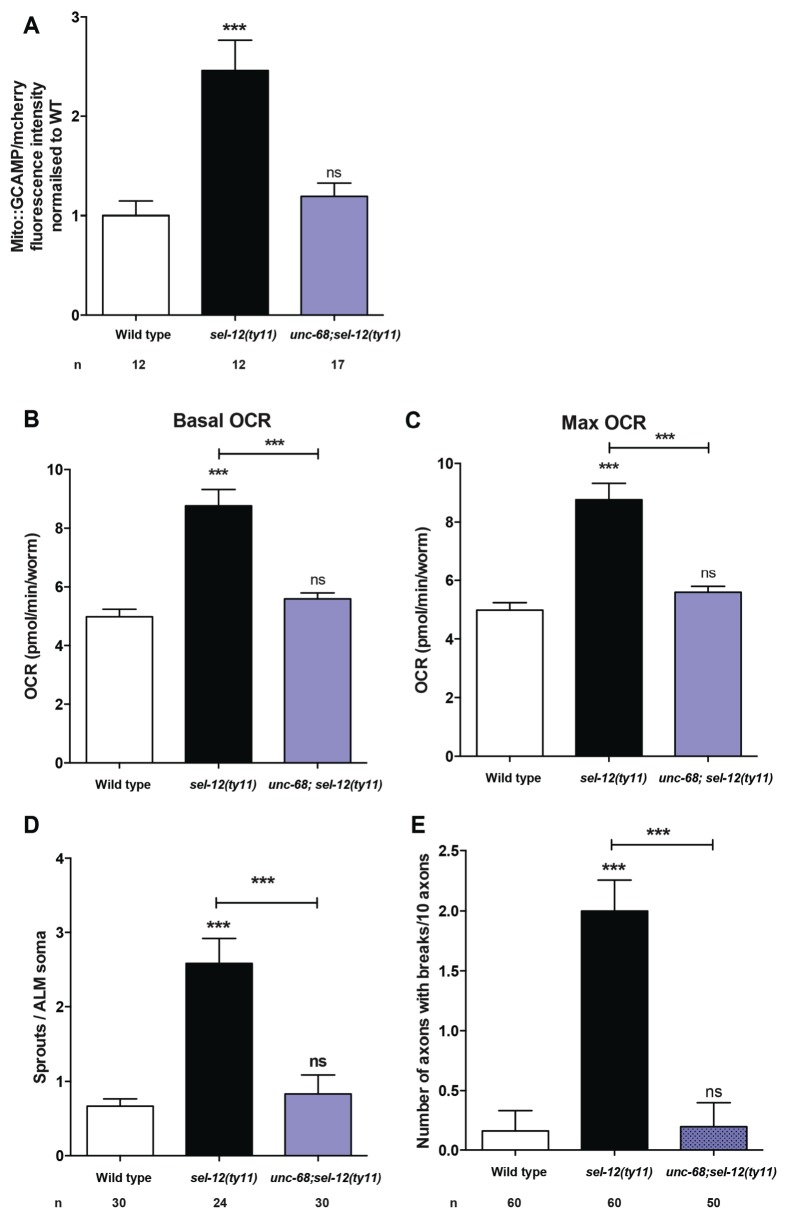
Loss of ryanodine receptors results in the improvement of neurodegeneration in sel-12 null animals.(A) Quantification of mitochondrial Ca2+ using animals expressing mito::GCaMP6 and mCherry in their mechanosensory neurons (takEx415). (B) Basal and (C) maximal respiration rates of wild type, sel-12, and unc-68; sel-12(ty11) mutant animals at day 1 of adulthood. (D) Quantification of aberrant structures (sprouts/branches) on ALM neuronal soma and (E) frequency of breaks in ALM and PLM neuronal processes at day 1 of adulthood. n = number of animals analyzed per genotype. Data are displayed as mean ± SEM, and all comparisons have been made to wild type animals unless otherwise indicated. ns p>0.05, ***p<0.0001 (One way ANOVA with Tukey test).10.7554/eLife.33052.025Figure 6—figure supplement 1—source data 1.Raw data for Figure 6—figure supplement 1.